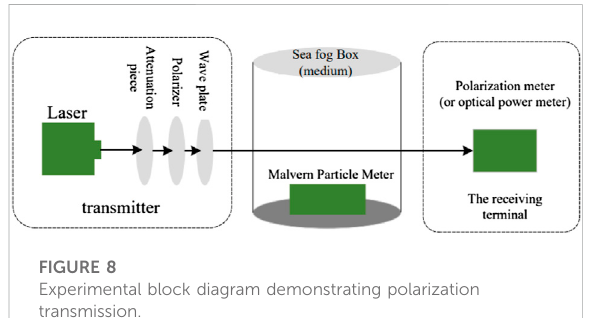
FIGURE 8 Experimental block diagram demonstrating polarization transmission.